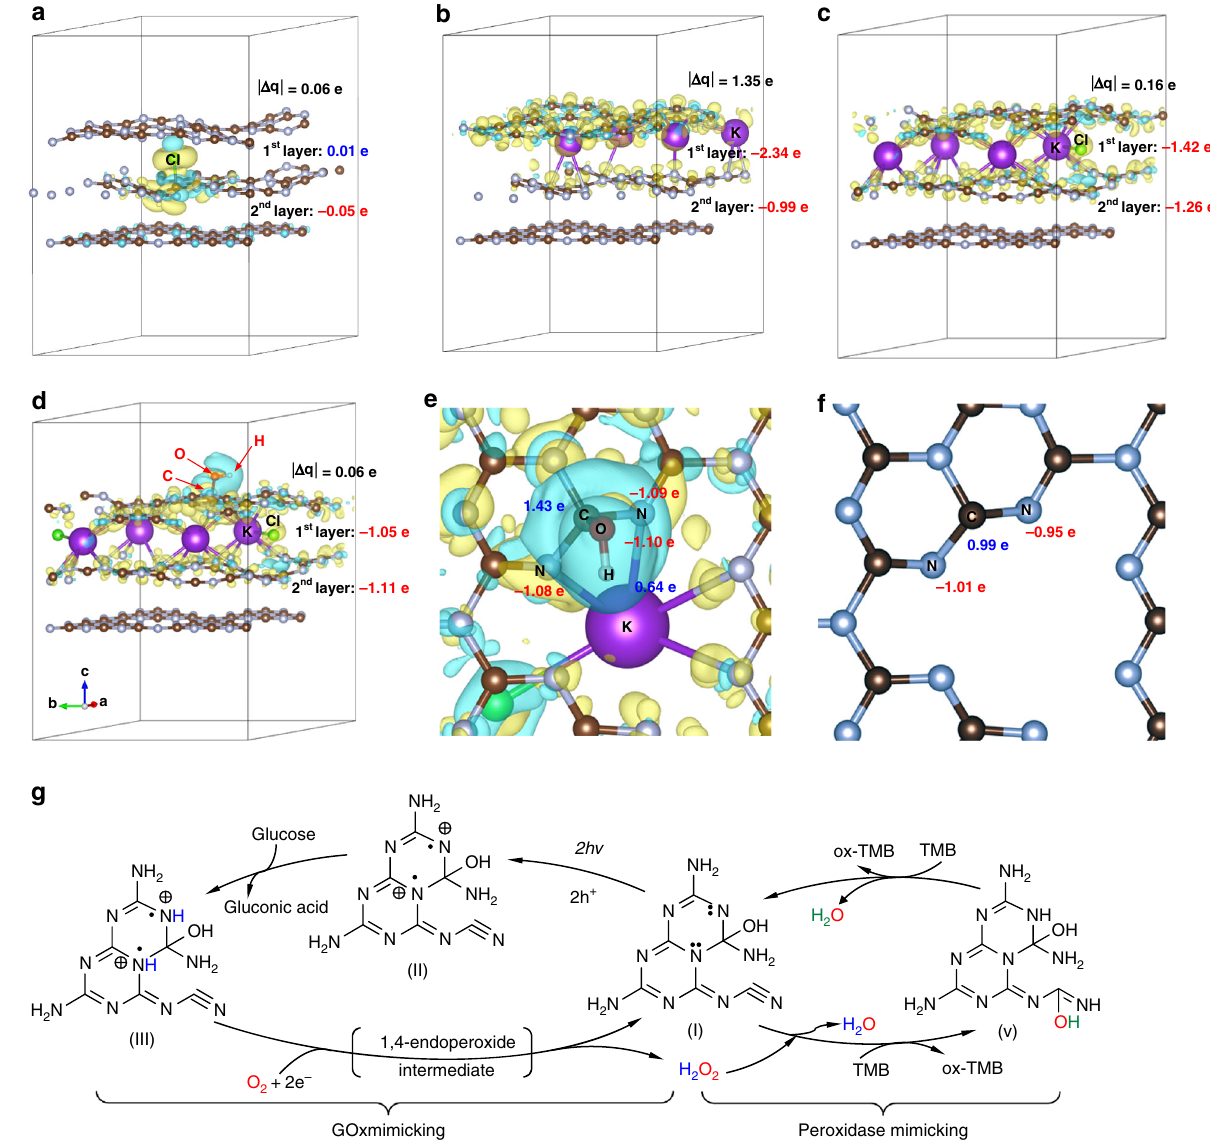
Fig. 8 Charge distribution analysis from density functional theory (DFT) calculations. Charge distribution of a Cl-GCN, b K-GCN, c KCl-GCN, d KCl-OH- GCN (i.e. AKCN), e an enlarged top view of KCl-OH-GCN, and f that of pristine GCN. g The effect of charge redistribution on the promotion of photocatalytic H 2 O 2 generation between GCN and AKCN. ǀ Δ q ǀ represents the absolute value of the difference of the electron distribution between the fi rst and second layer. Yellow colour represents electron accumulation and blue colour represents electron depletion. A negative value means that accumulation of the electron based on the valence electron. Isovalue is taken as 0.002. Brown and grey colour represent carbon and nitrogen, respectively. Source data are provided as a Source Data fi